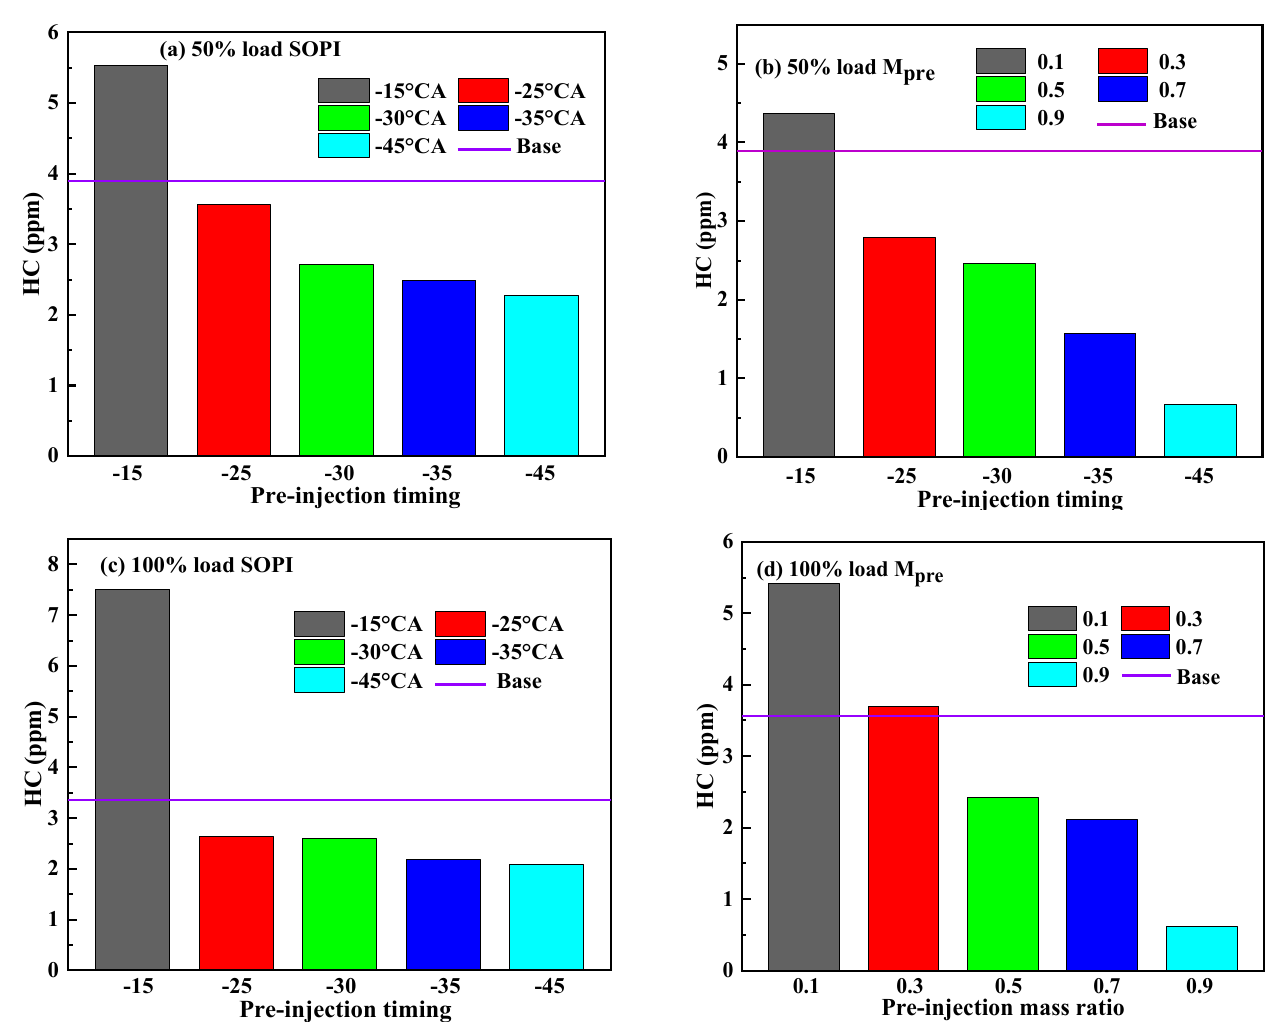
Figure 14. Comparison of HC changes under different load conditions.